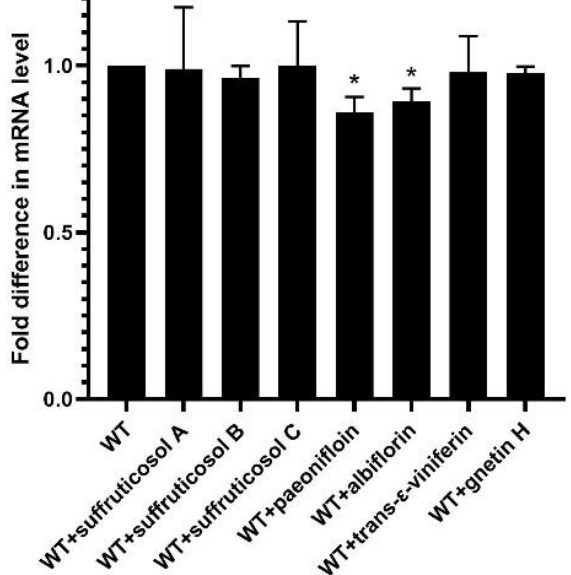
Figure 5. Relative expression of luxS genes. The figure shows that the gene expression level in the WT strain is 100%. Data from three independent assays are expressed as mean ± SD. Statistical significance was assessed by unpaired Student’s two-sided t -test compared to the control group. * p <